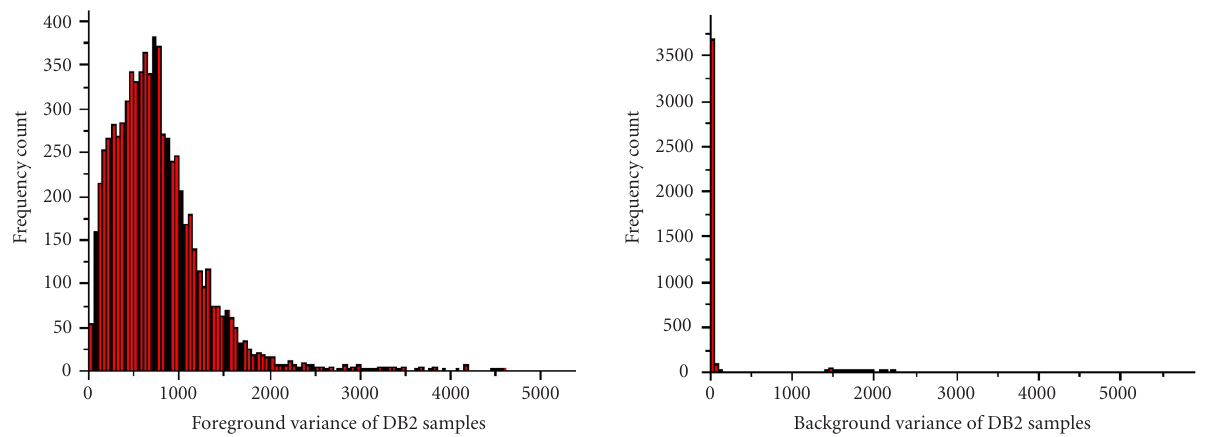
Figure 17: The block variance Var of the samples. The horizontal coordinate represents the value of the block variance while the vertical coordinate represents the frequency count of the value.